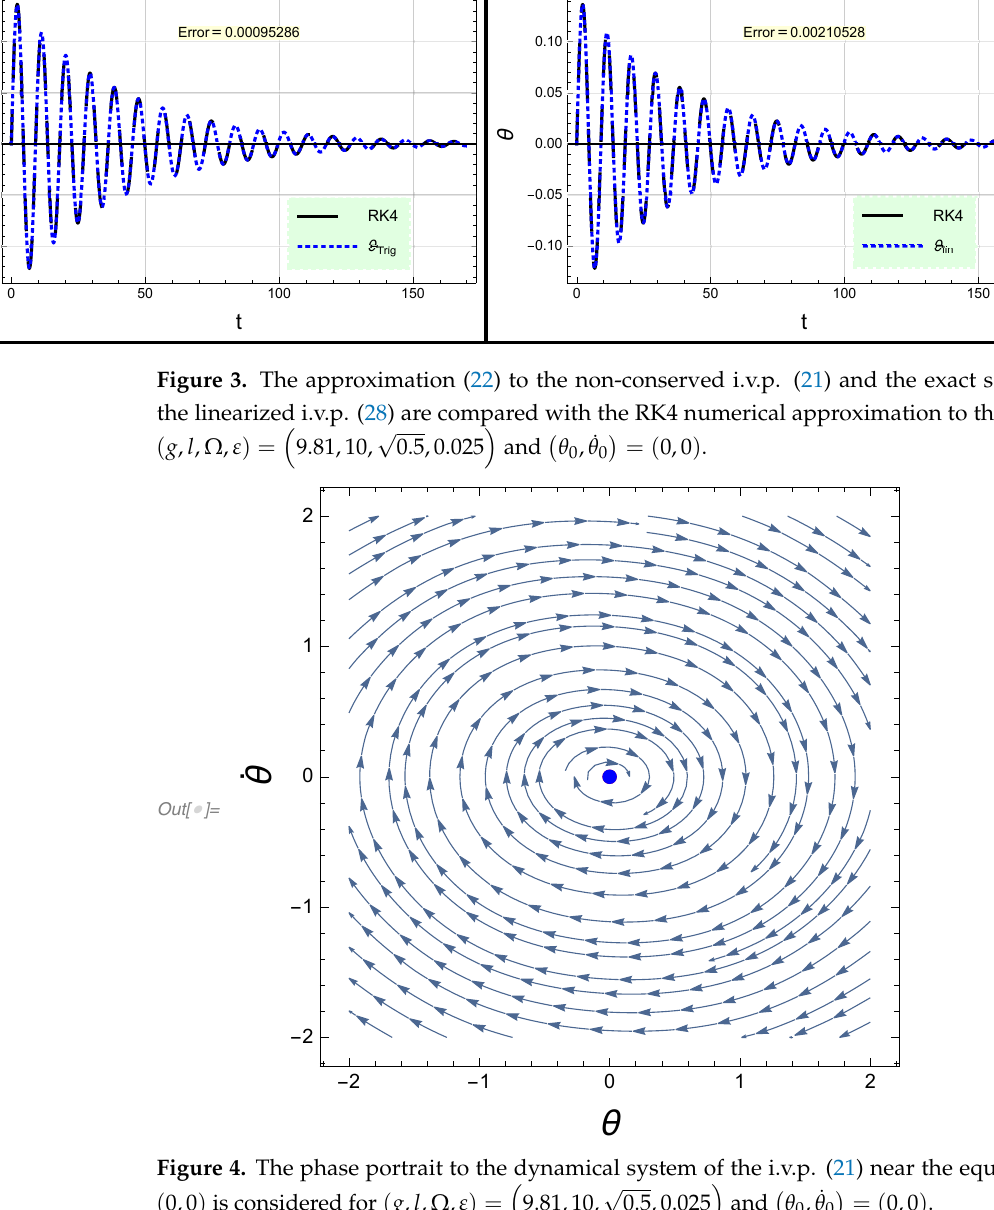
√ (cid:16) (cid:17) (cid:0) (cid:1) = ( θ 0 , ˙ θ 0 9.81,10, 0.5,0.025 and 0,0 )